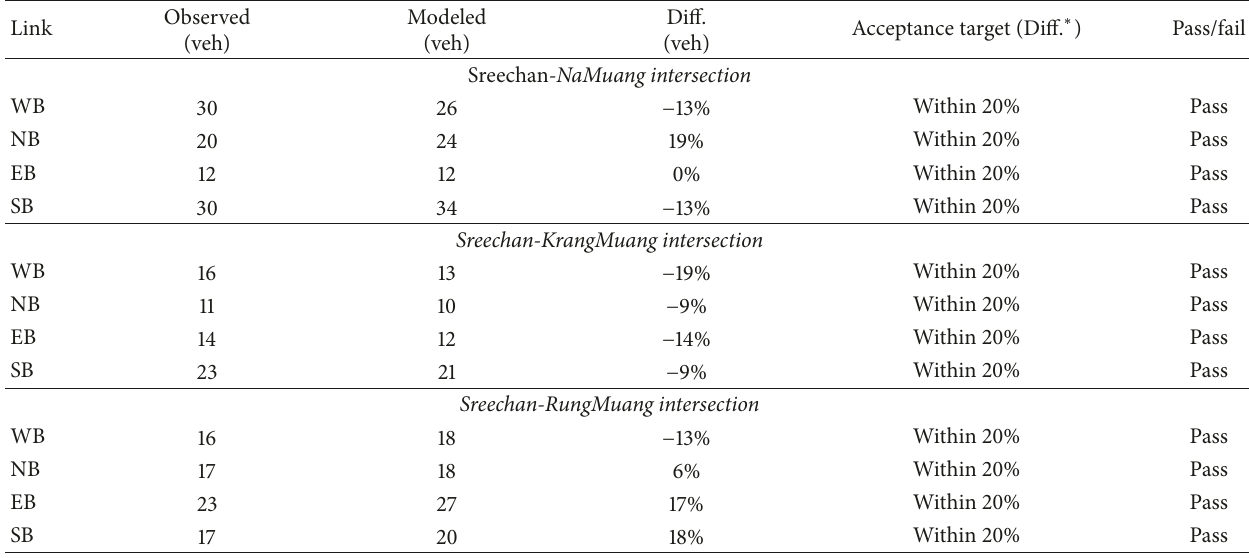
Table 3: Results of the model calibration of the maximum queue length.